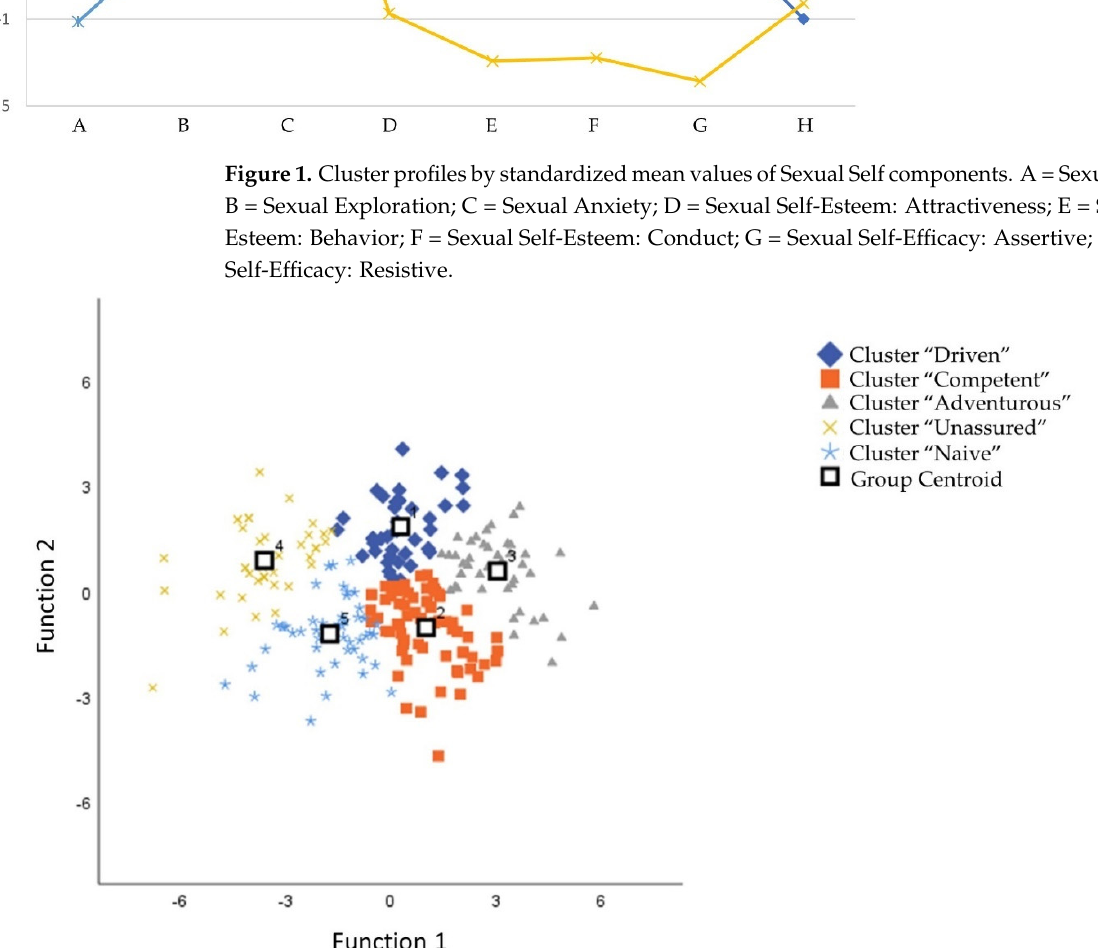
Figure 2. Five-cluster solution plotted in discriminant function space.